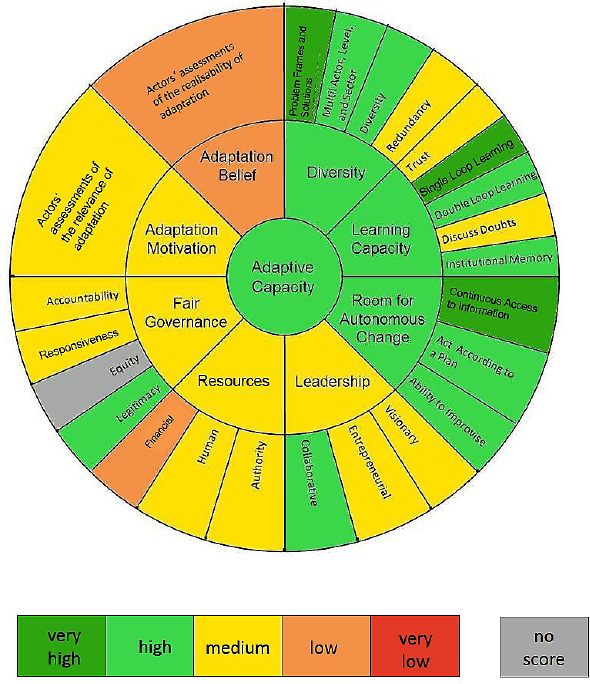
Fig. 3. Exemplary Adaptive Capacity Wheel for water management in northwestern Germany (cf. Grecksch,